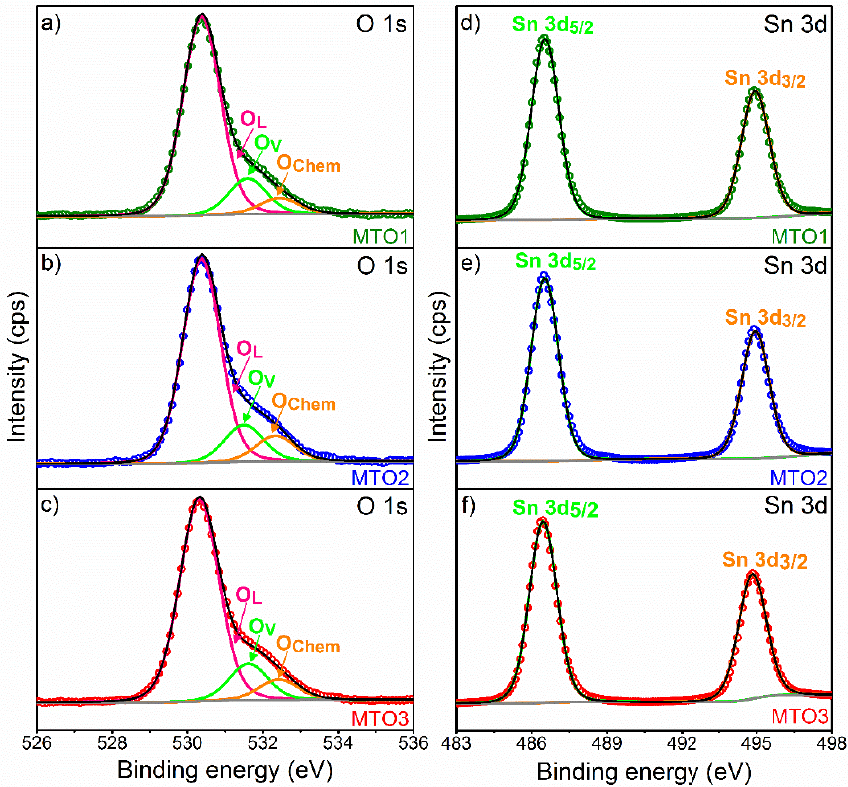
Figure 5. Deconvolution of O 1s ( left figure ) and Sn 3d ( right figure ) XPS core level spectra, (( a ) and ( d )) MTO1; (( b ) and ( e )) MTO2; (( c ) and ( f )) MTO3. The circles denote experimental data, colored lines demonstrate the deconvolution of peaks, and the black line corresponds to the sum of peaks fits (envelope).